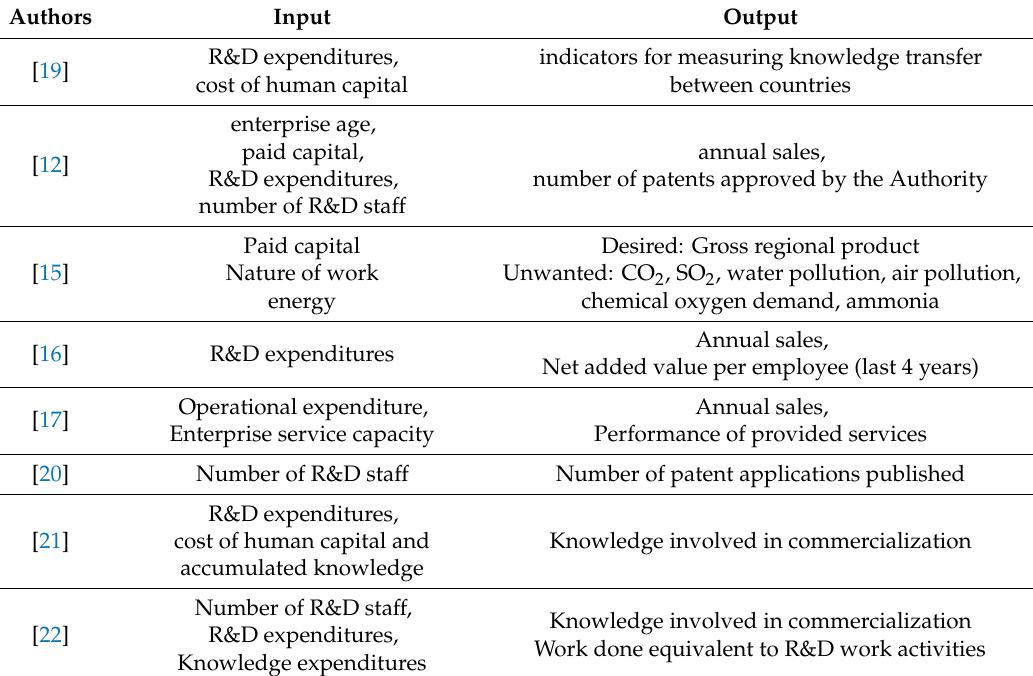
Table 1. Input and output factors of innovation for data envelopment analysis (DEA) analysis from similar